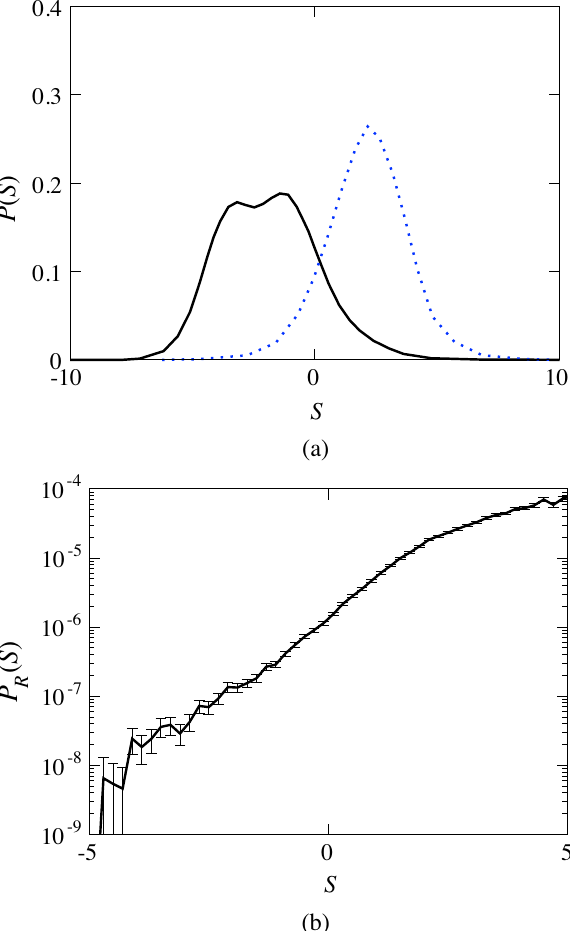
FIG. 5. Performance of machine-learned softness. (a) The dis- tribution of softness for all particles (black solid curve) and for rearrangers only (blue dotted curve). There is a pronounced differ- ence between the two distributions. The two peaks in the black solid curvecomefromparticleswithfourandfiveneighbors,respectively, as we demonstrate in the Supplemental Material [25]. (b) The probability that a particle is rearranging P softness. As the softness increases, P P ð r ; δ f Þ , where F magnitude, verifying the high correlation between softness and δ f ¼ 0 g 2